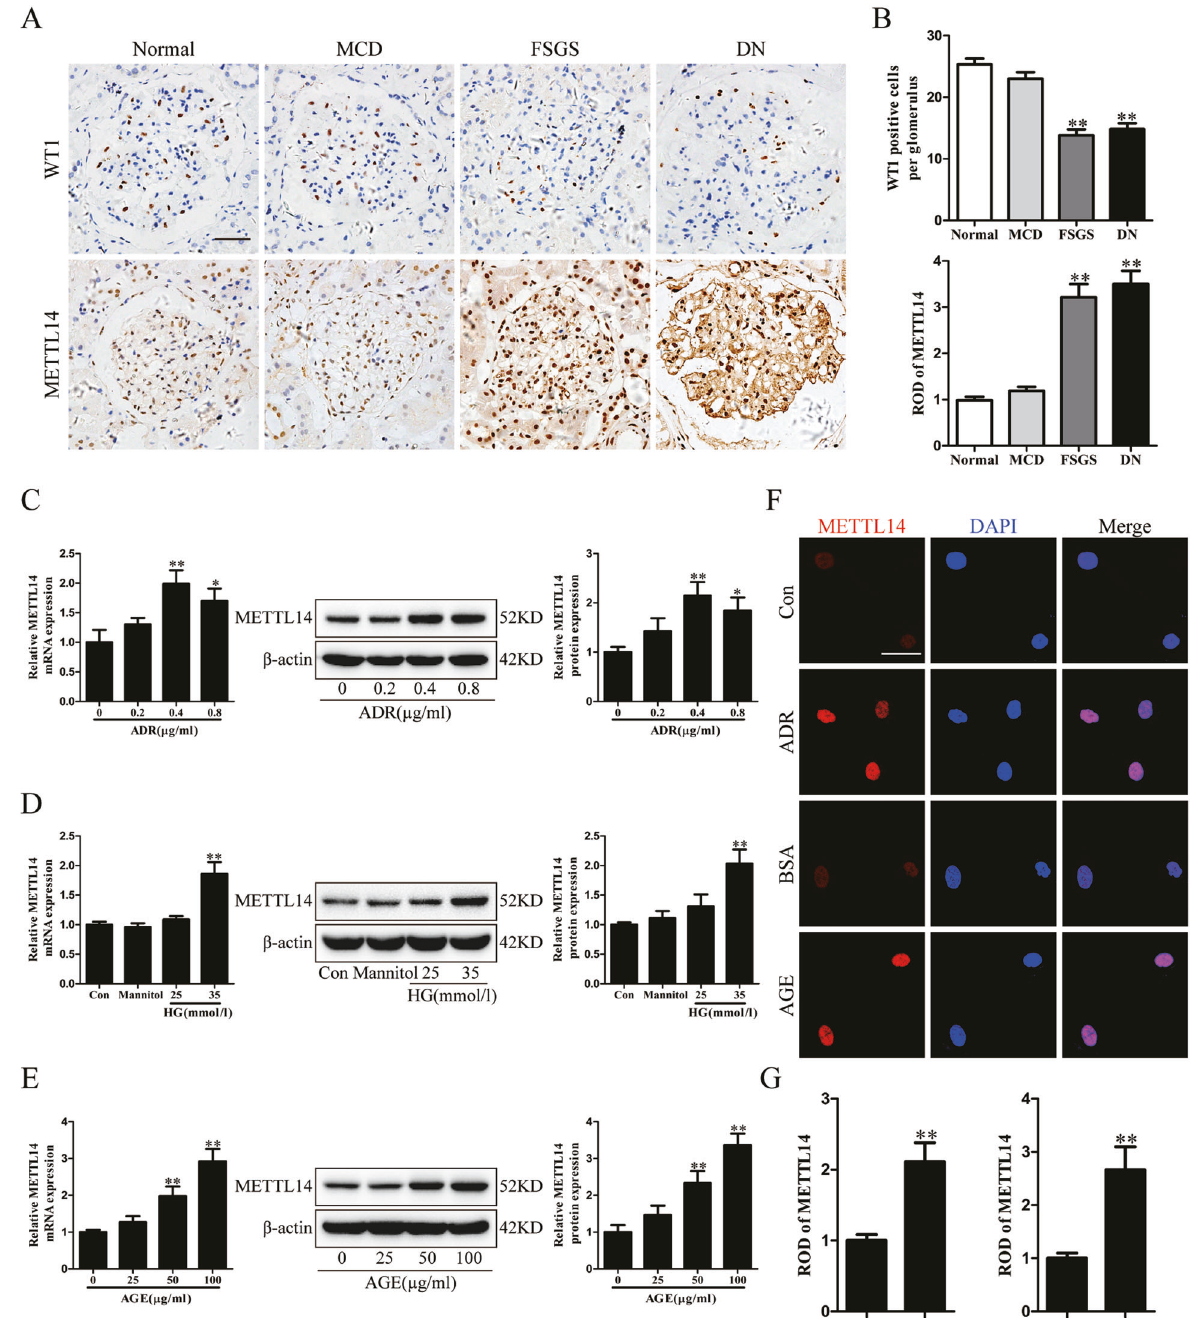
Fig. 2 The elevated METTL14 expression in patients with podocytopathies and injured podocytes in vitro. A , B Representative images and quanti fi cation of immunohistochemical staining for METTL14 and WT1 on renal biopsy samples from normal subjects ( n = 4) and patients with MCD ( n = 6), FSGS ( n = 6) and DN ( n = 8). Scale bars, 20 μ m. ** P < 0.01 vs. normal subjects. C Quantitative RT-PCR and western blot analysis of METTL14 mRNA and protein expression in human cultured podocytes administrated with different doses of ADR (0.2 − 0.8 μ g/ml) for 24 h ( n = 6). D Quantitative RT-PCR and western blot analysis of METTL14 mRNA and protein levels in podocytes subjected to different doses of HG (25 or 35 mmol/l) for 24 h ( n = 6). E Quantitative RT-PCR and western blot analysis of METTL14 mRNA and protein expression in podocytes treated with different doses of AGE (25 − 100 μ g/ml) for 24 h ( n = 6). F Representative confocal microscopic images of immuno fl uorescence staining for METTL14 in podocytes treated with ADR (0.4 μ g/ml) or AGE (50 μ g/ml) compared with normal controls. G Quantitative analysis of immuno fl uorescence staining for METTL14 in podocytes subjected to ADR (0.4 μ g/ml) or AGE (50 μ g/ml) in comparison to normal controls ( n = 6). Data are presented as mean ± SEM. * P < 0.05, ** P < 0.01 vs. control group.